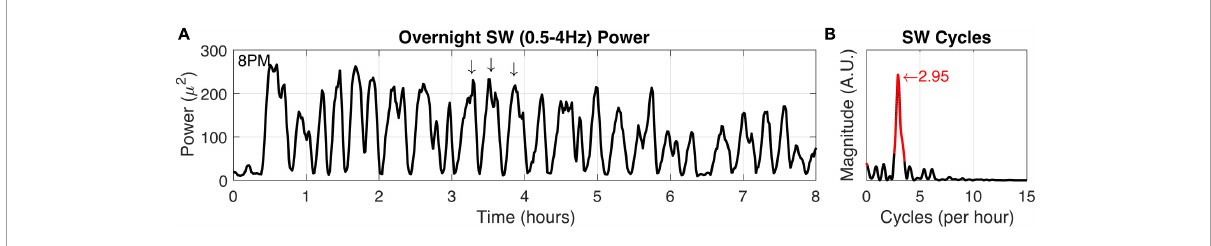
FIGURE6 Squirrel SW cycle duration. (A) Power in the SW band (0.5–4 Hz) was calculated from overnight recording data (8 h). Arrows indicate high SW power and also demonstrate characteristic SW cycle frequency in a 1-h window. (B) The SW time-frequency relationship was calculated to determine fundamental frequencies that may occur in the SW activity. Highly significant ( P < 0.001) values and the peak magnitude were calculated (both in